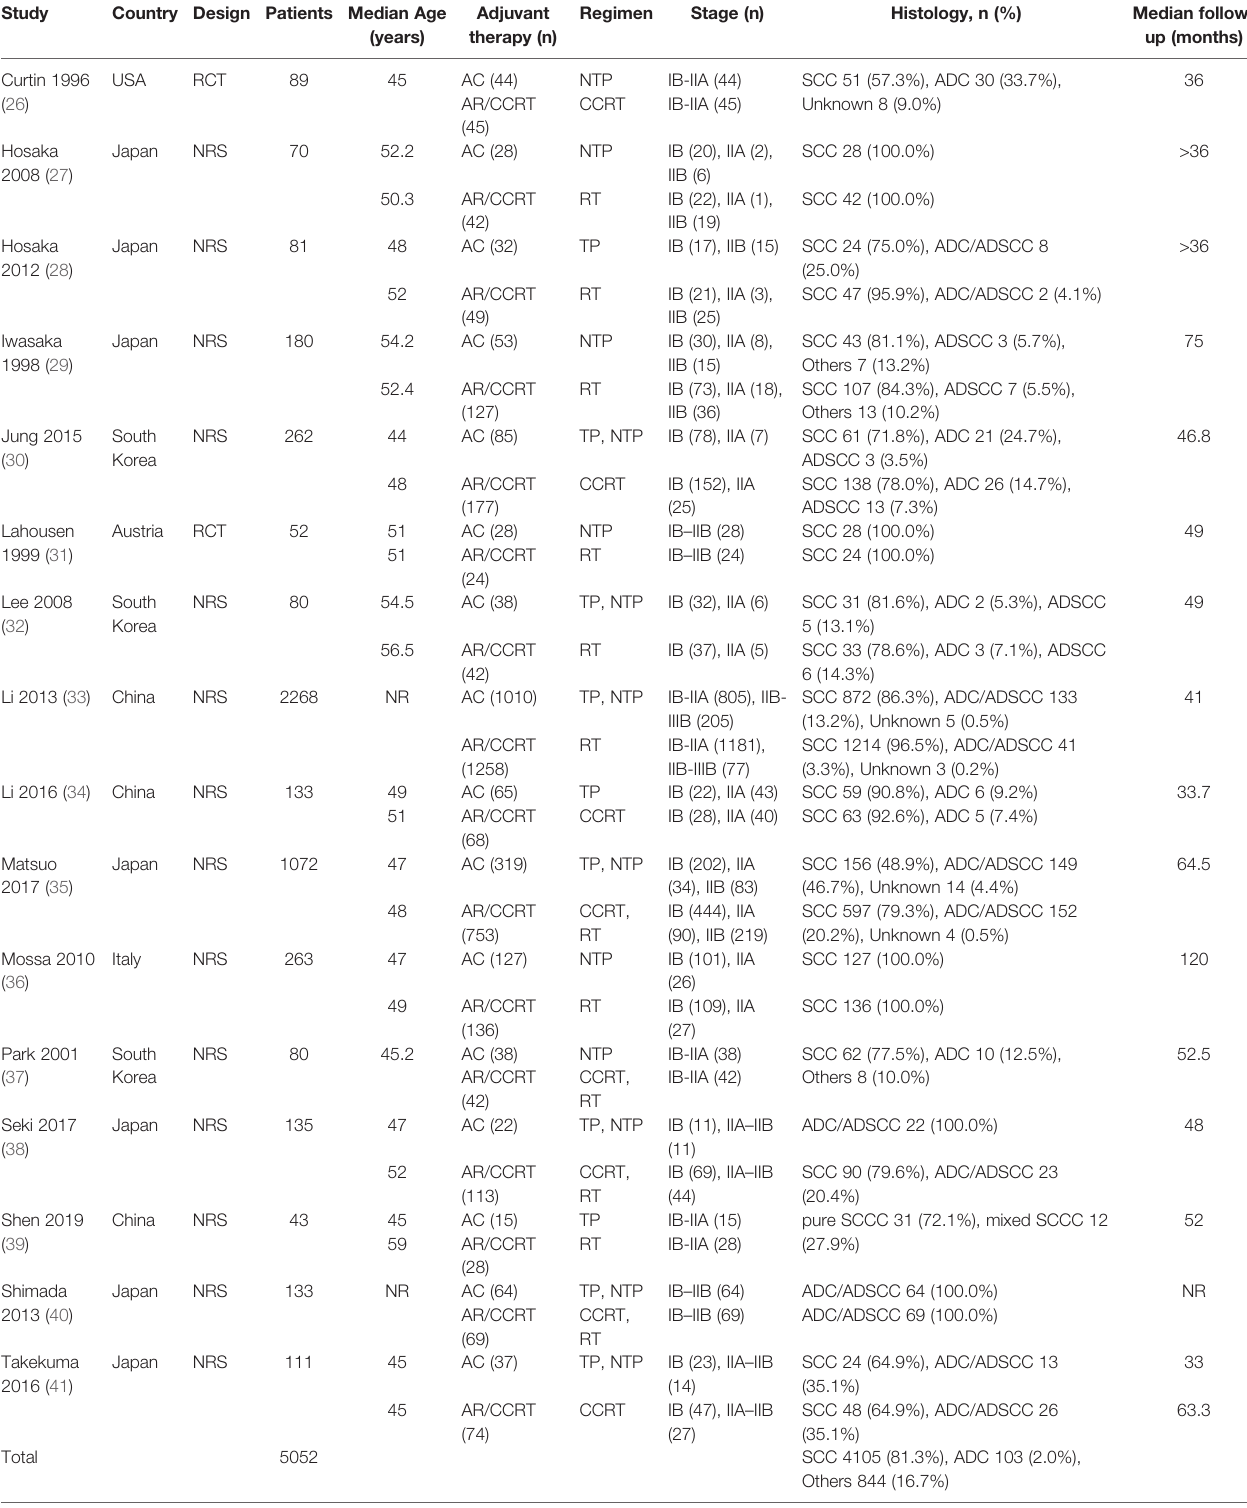
TABLE 1 | Characteristics of included studies.